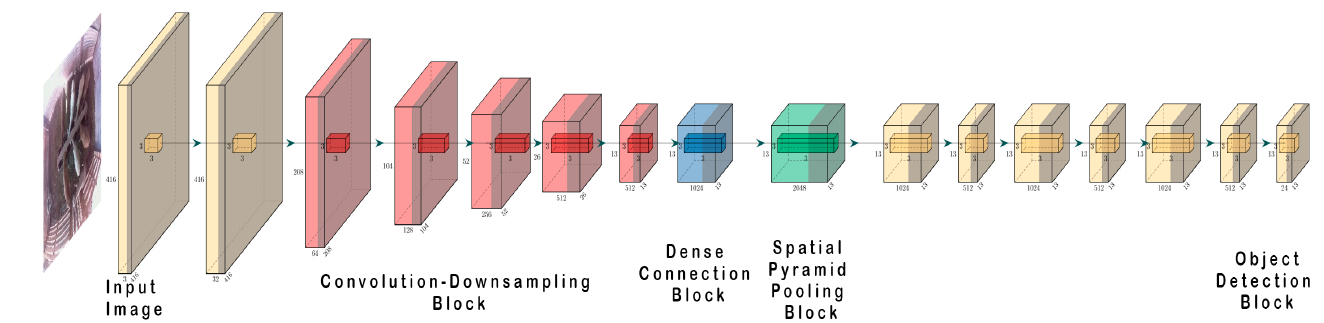
Figure 4. Custom YOLO V 4 network